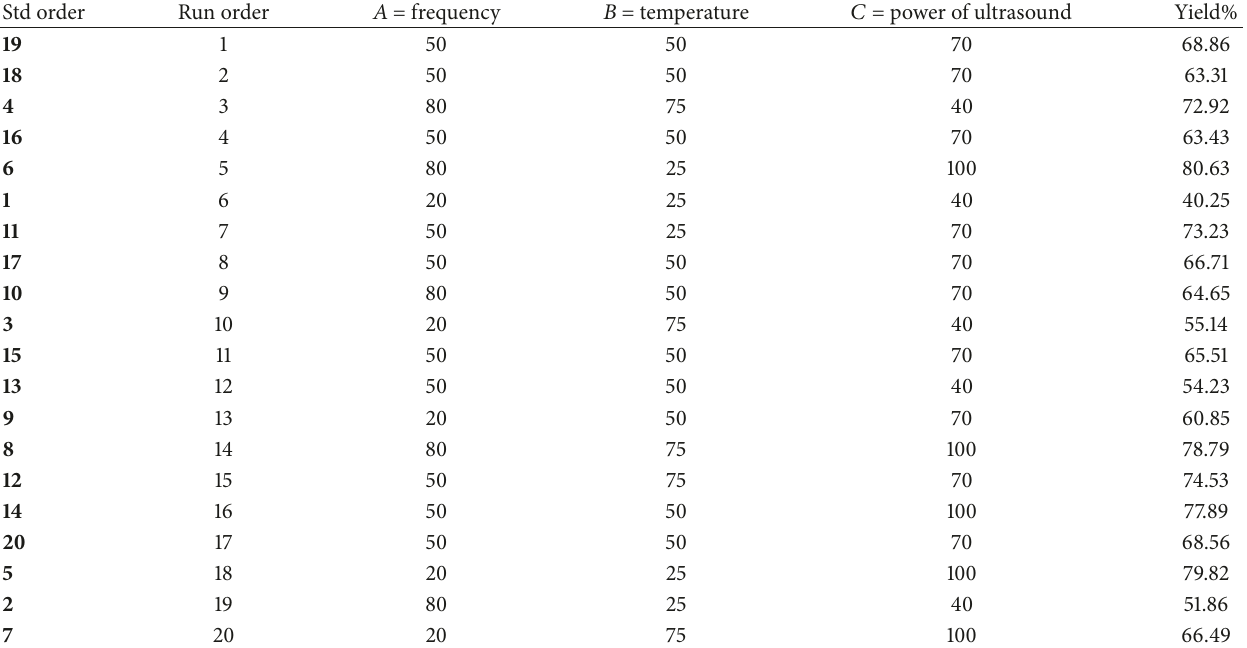
Table 2: Experimental design recommended by Design-Expert for ultrasound-assisted extraction.